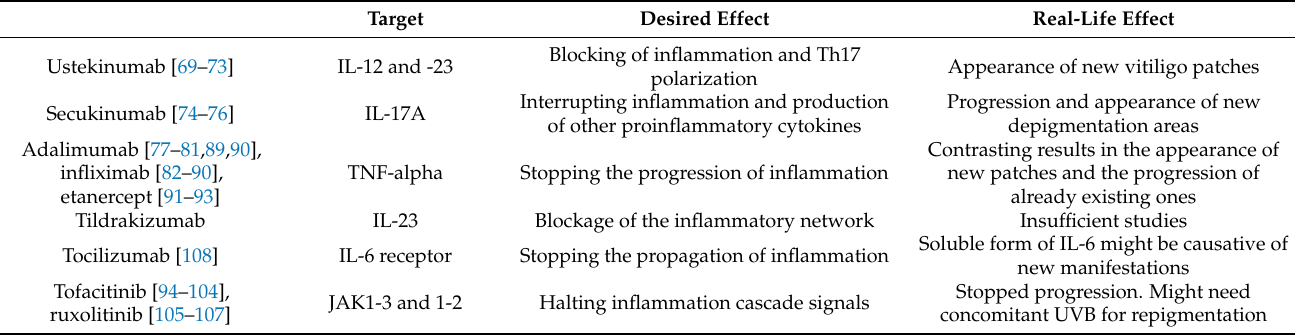
Table 1. Biological drugs used for the treatment of